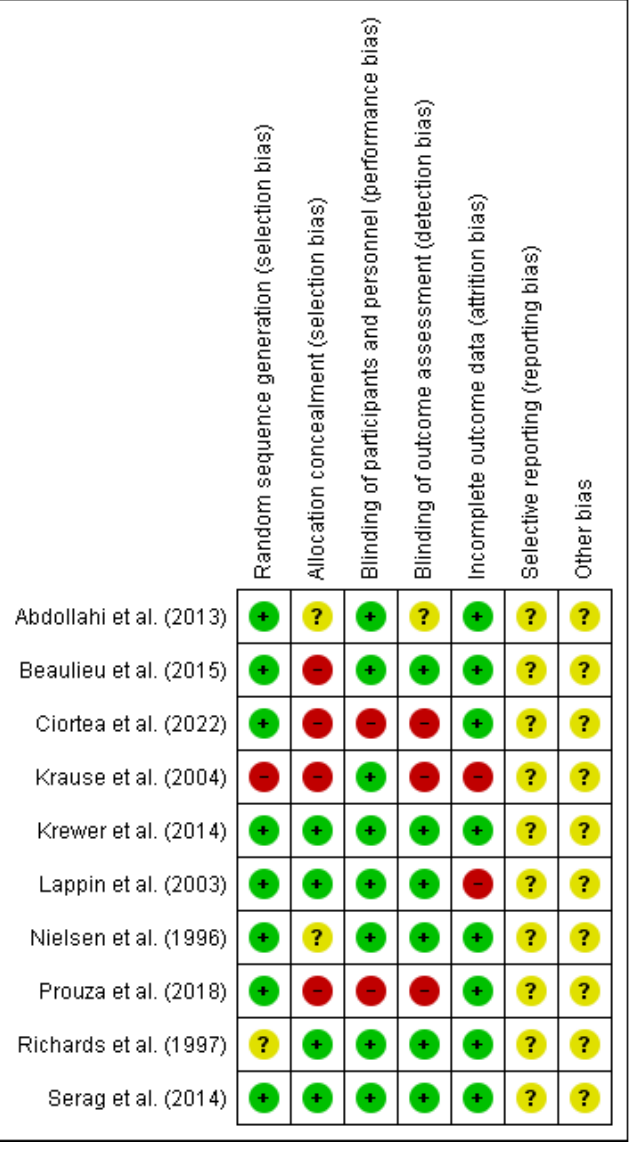
Figure 2. Risk of bias summary [32–41].